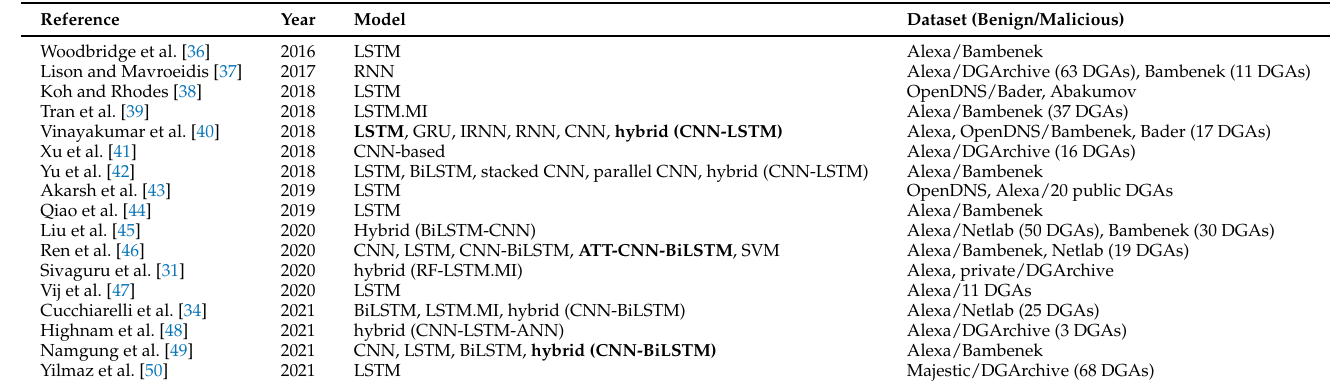
Table 2. DGA-based botnet detection using featureless DL models.